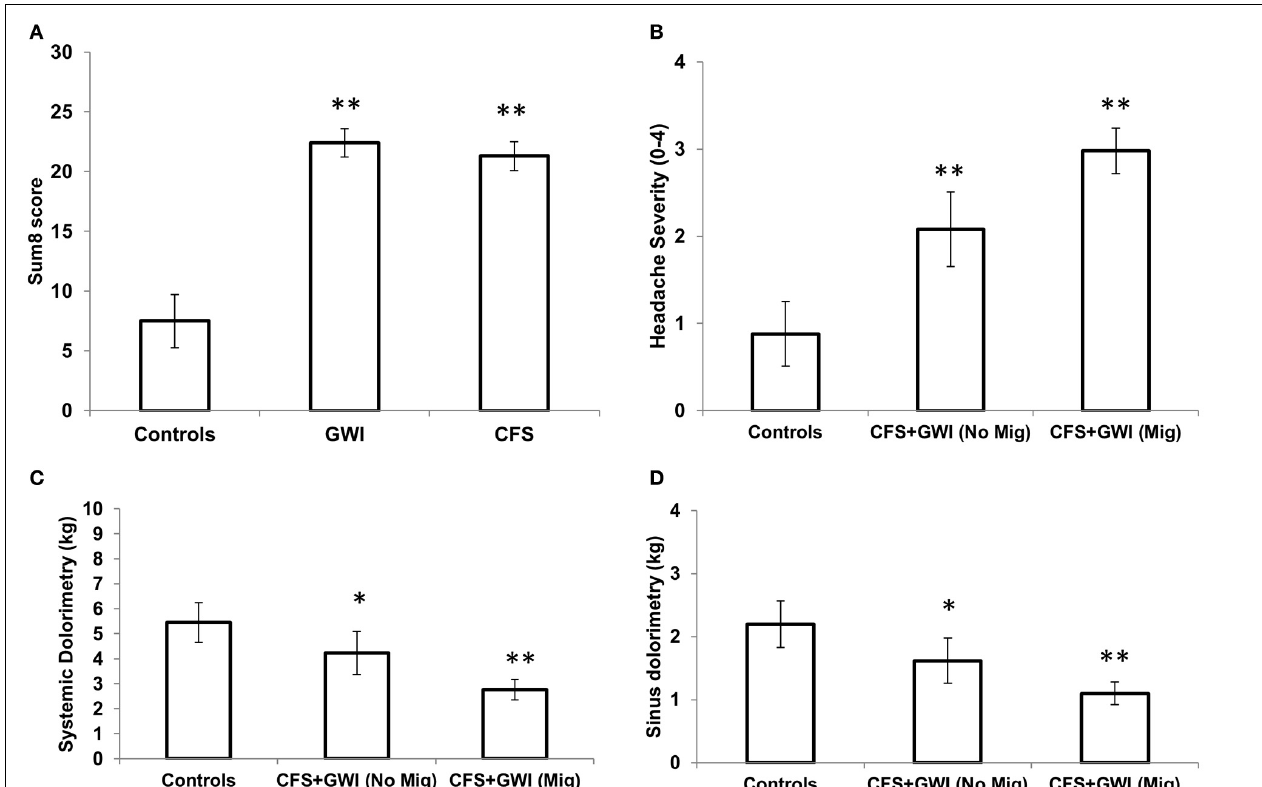
FIGURE 3 | Sum8 and comparison between CFS and GWI subjects based on migraine status. (A) Sum of 8 scores which total the 8 ancillary criteria from the CFS severity score. (B) CFS and GWI subjects were combined to show that migraineurs ( n = 64) had higher ratings of headache severity (2.9 [2.7–3.2]) compared to CFS and GWI subjects with no migraines (2.1 [1.6–2.5]; n = 25) and controls (0.88 [0.51–1.3]; n = 45). (C) CFS and GWI